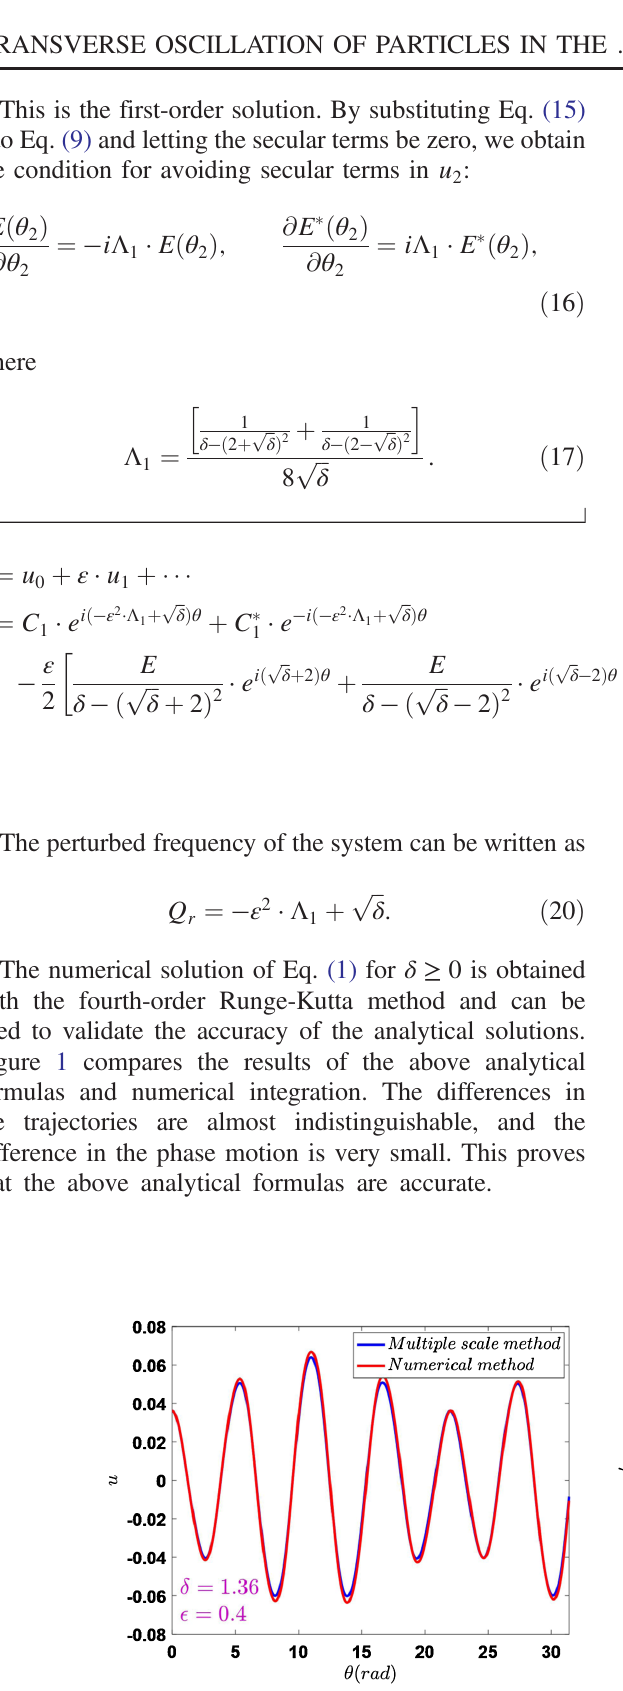
FIG. 1. Trajectories (left) and phase motions (right) for parameter pairs ð δ ; ε Þ ¼ ð 1 . 36 ; 0 . 4 Þ in the stable region. The MMS is in blue, and the direct numerical integration is in